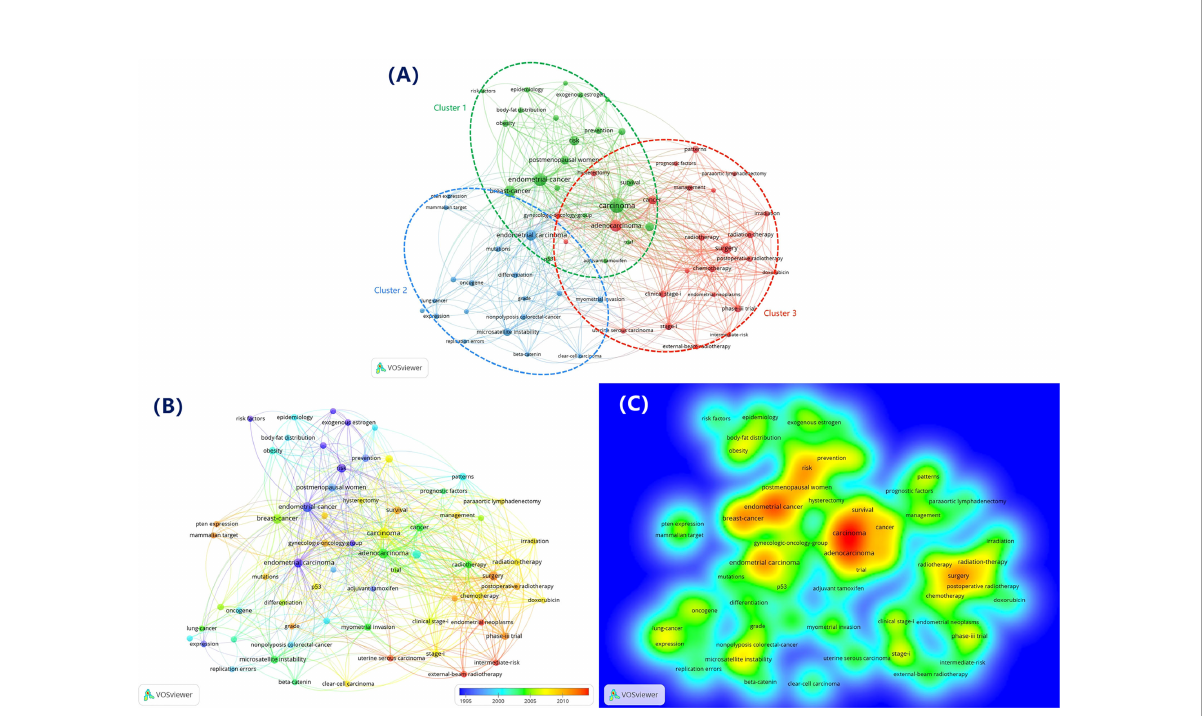
FIGURE 5 (A) Network visualization map showing co-occurrence keywords. (B) Overlay visualization map showing co-occurrence keywords based on the mean publication year. (C) Density visualization map showing co-occurrence keywords based on the mean frequency of appearance.